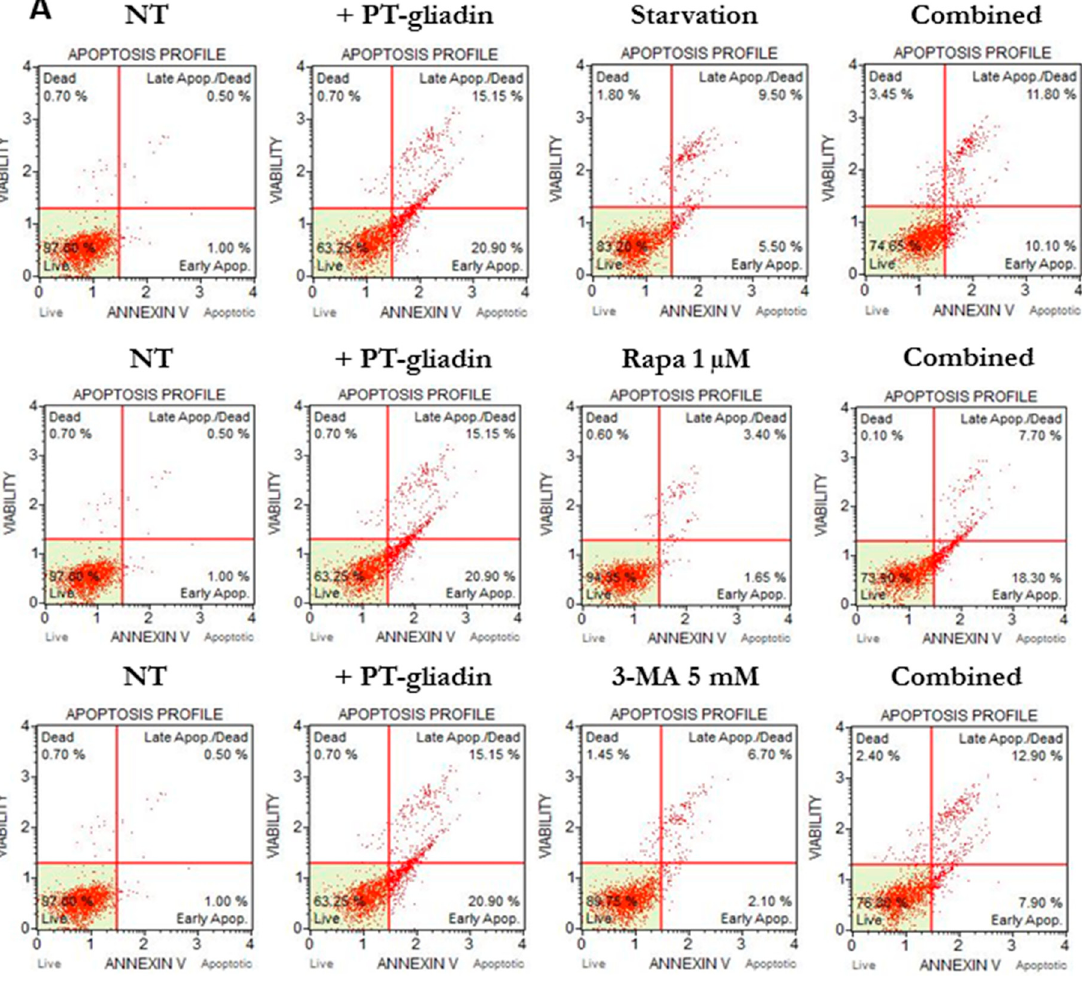
Figure 13. Apoptotic analysis of Caco-2 cells after PT-gliadin administration and autophagy modulation protocols. ( A ) Cytofluorimetric plots of apoptotic profiles of Annexin V expression, for single and combined treatments (starvation, rapamycin and 3-methyladenine) summarized, as total apoptotic events (Early + Late) in Panel ( B ). 3. Discussion In this work, in vitro experiments were conducted to elucidate the autophagy involvement in the cellular response to PT-gliadin administration. The working hypothesis was that the autophagy process, in its catabolic function of unselective degradation of bulk exogenous proteins, might reduce the toxicity of gliadin proteins. To this purpose, after the evaluation of the effect of PT-gliadin on the